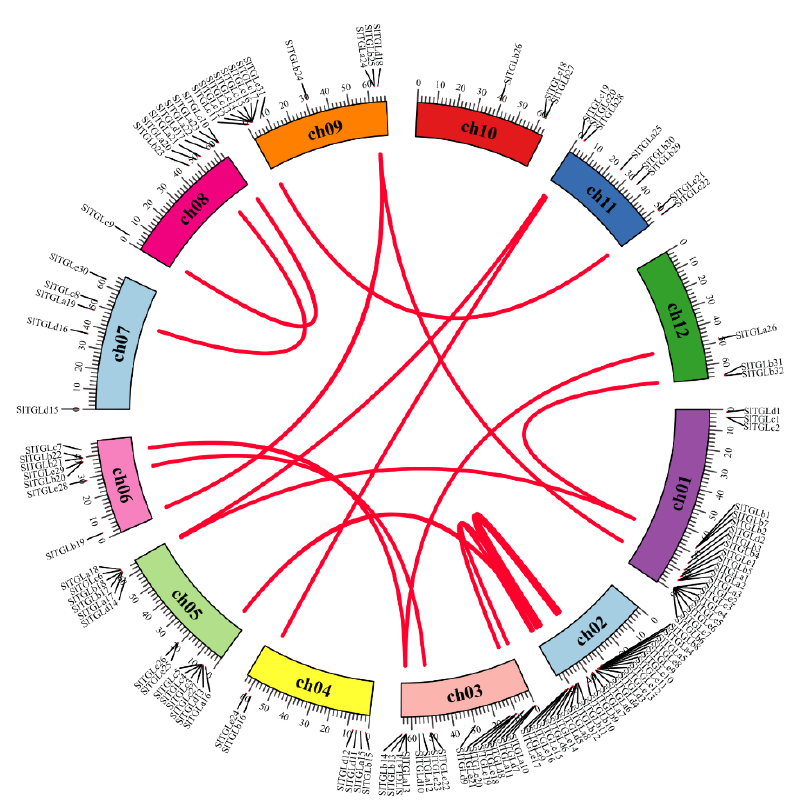
Figure 3. Distribution and segmental duplication of SlTGL genes in tomato. The panel shows the 12 chromosomes using a circle; red lines connecting homologous genes; chromosome numbers are marked inside of the circle.